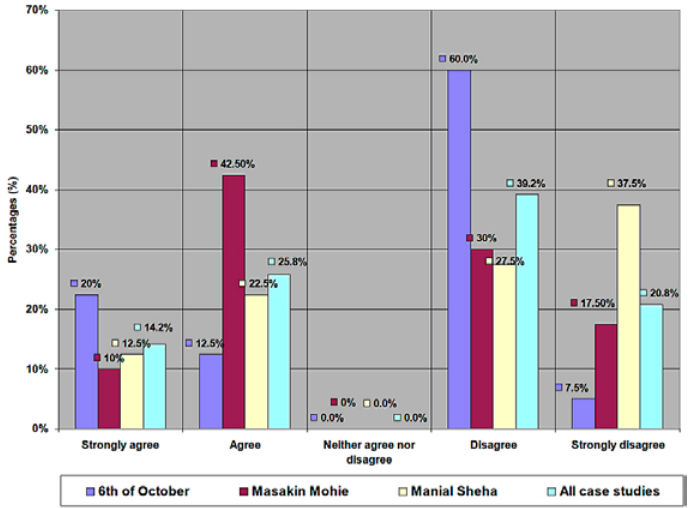
fig. 8. The government should control the temporary residents’ appropriation of open spaces and